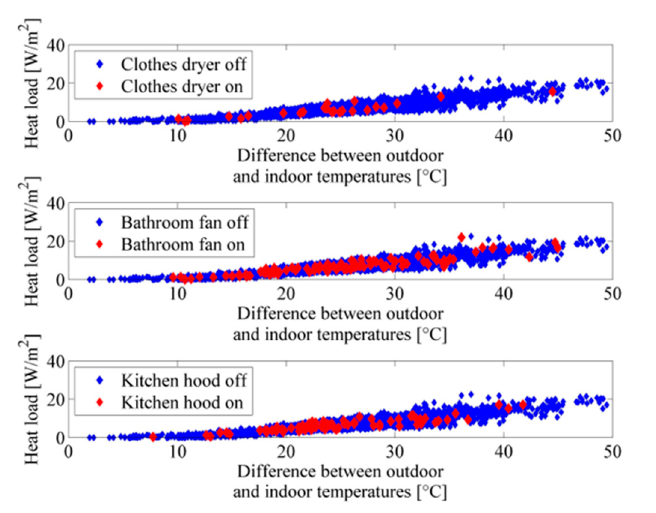
Figure 4. Influence of the exhaust fans on the relation between the heating load of a dwelling during the heating season (November to April) and the difference of temperature between indoor and outdoor